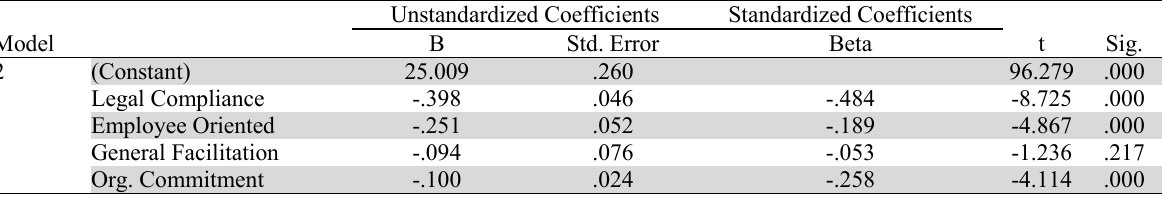
The results of regression analysis for model 2 Model